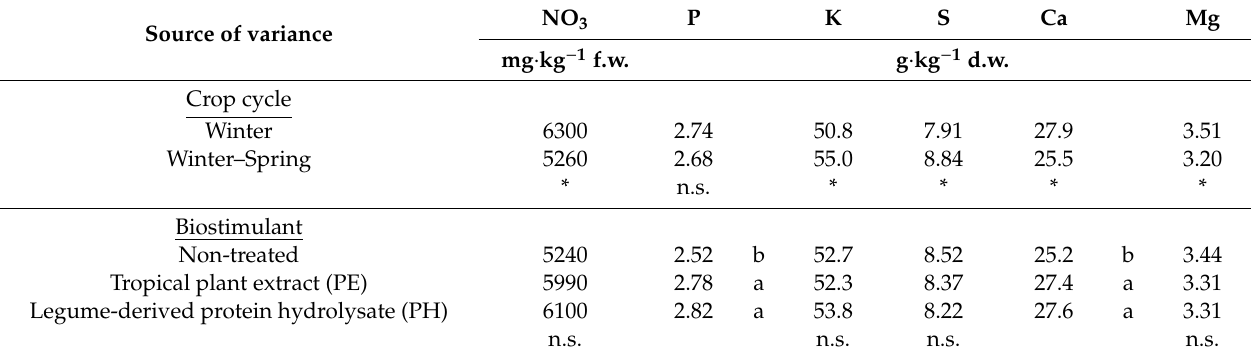
Table 4. Mean values of mineral composition of perennial wall rocket leaves as a ff ected by crop cycle and biostimulant. Source of